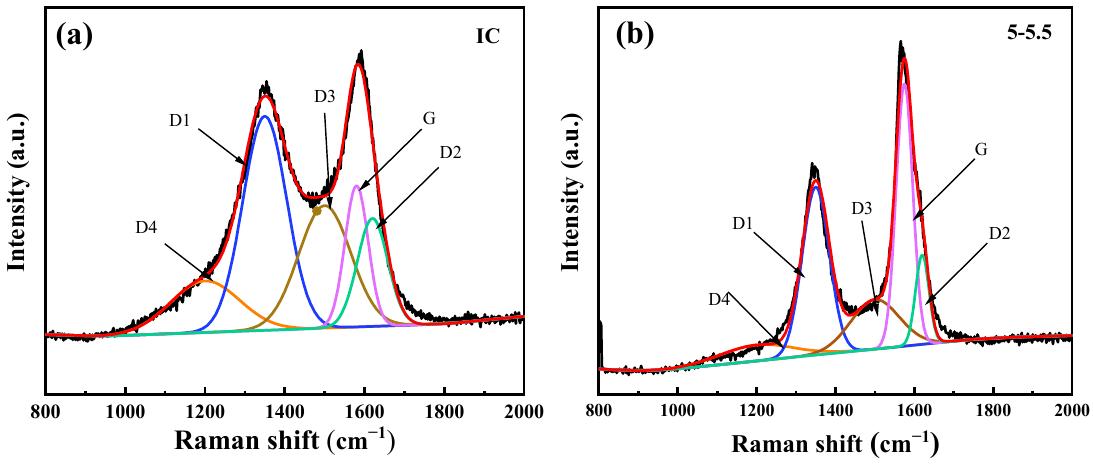
Figure 11. Fitting spectrum of IC and TC. ( a ) IC; ( b ) TC (5–5.5 m). Table 7. Meaning of peak area ratio of characteristic peaks.